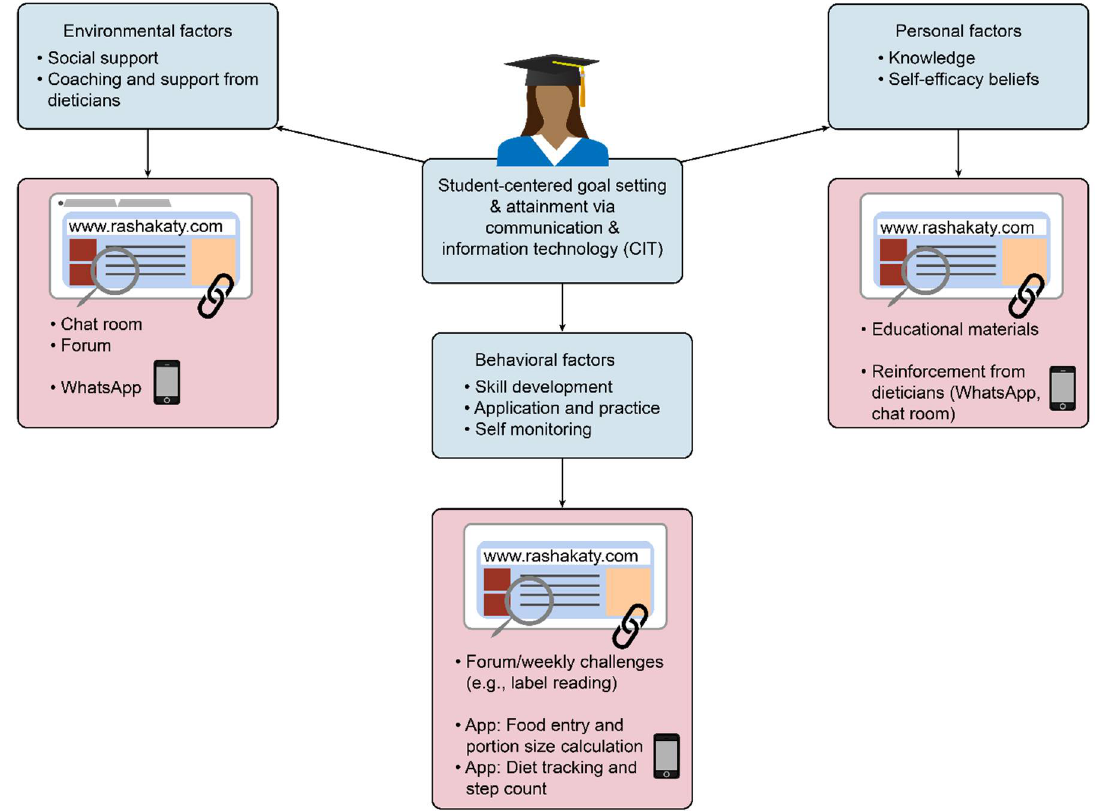
Figure 2. Application of social cognitive theory in R-Enhanced